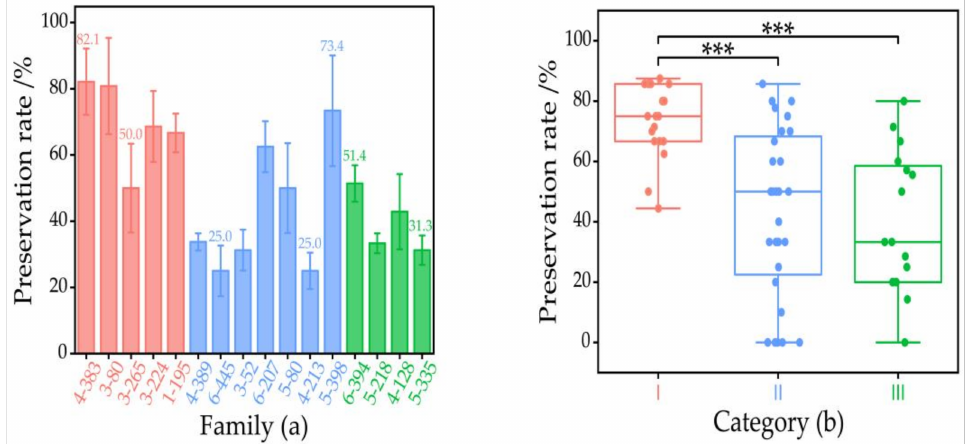
Figure 3. Preservation rate analysis among the tested families. ( a ): Histogram of preservation rate (%) for the tested families. ( b ): Analysis of the difference of preservation rate (%) of different drought resistant categories. Red represents drought-resistant families, blue indicates intermediate drought tolerance families, and green represents drought-sensitive families. The number indicates the maximum and minimum values of preservation rate (%) with different drought resistance levels. “***”: p < 0.001.